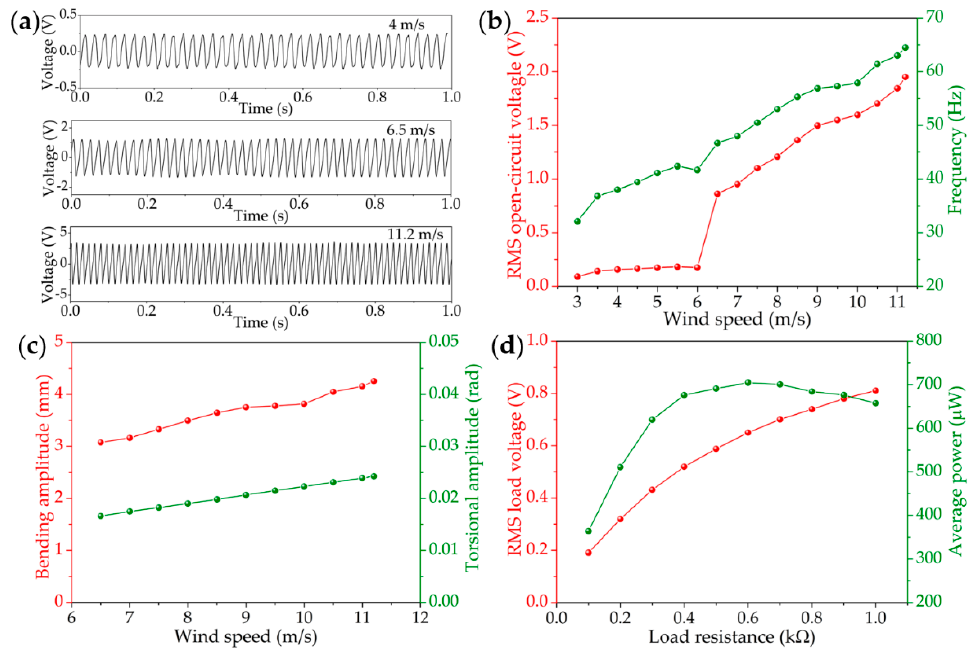
Figure 5. ( a ) The open-circuit voltage waveform at different wind speeds. ( b ) The RMS open-circuit voltage and the corresponding frequency as a function of wind speed. ( c ) The relationship between the derived bending and torsional amplitudes, and wind speed. ( d ) The RMS load voltage and derived average power as a function of load resistance at wind speed of 10 m/s.